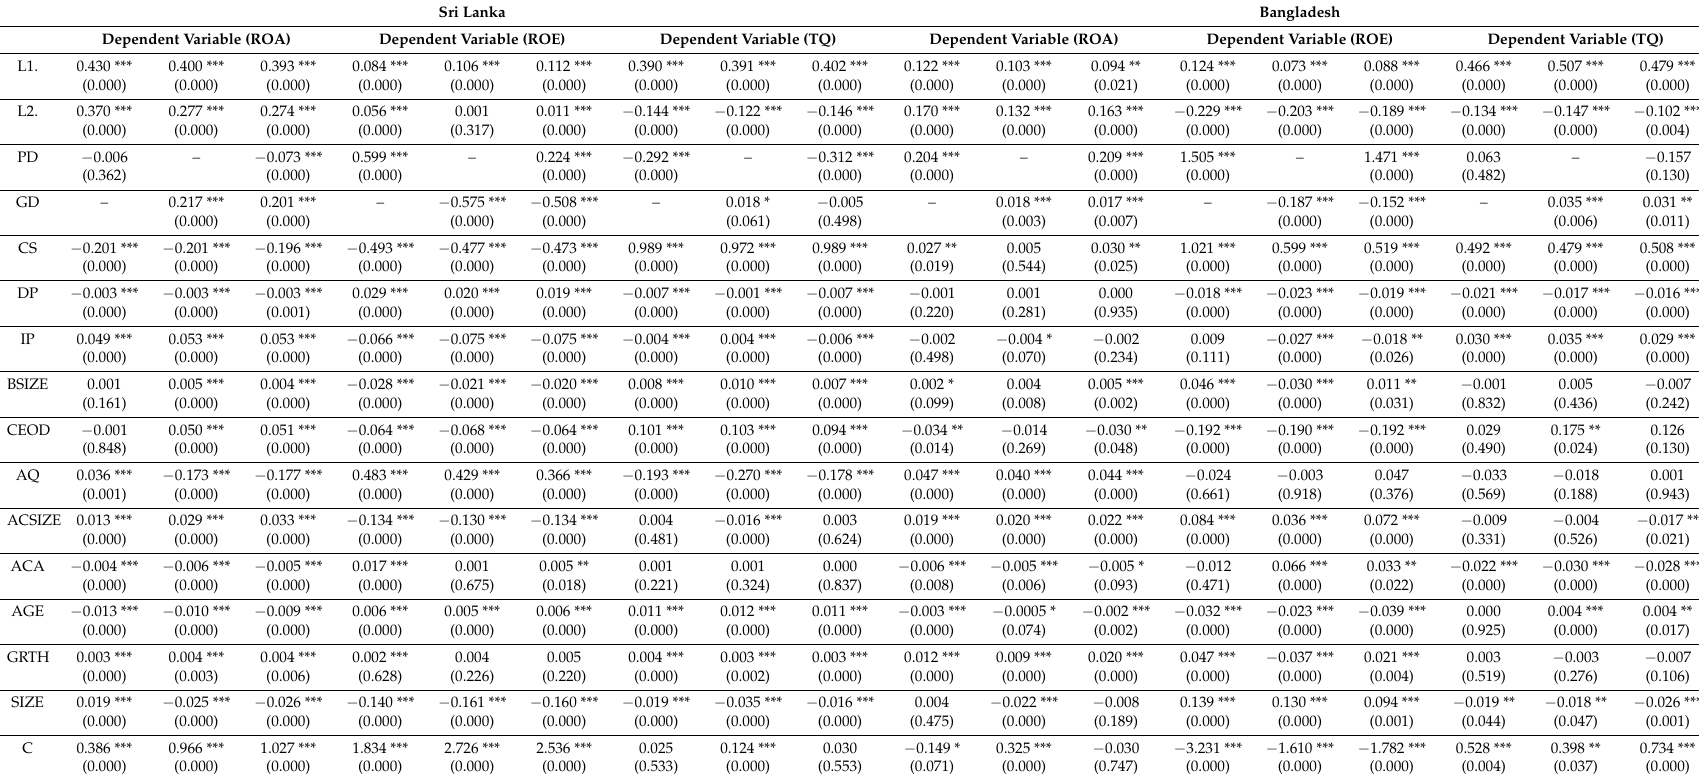
Table 7. Two-step System Dynamic Panel Regression (Sri Lanka and Bangladesh). Sri Lanka